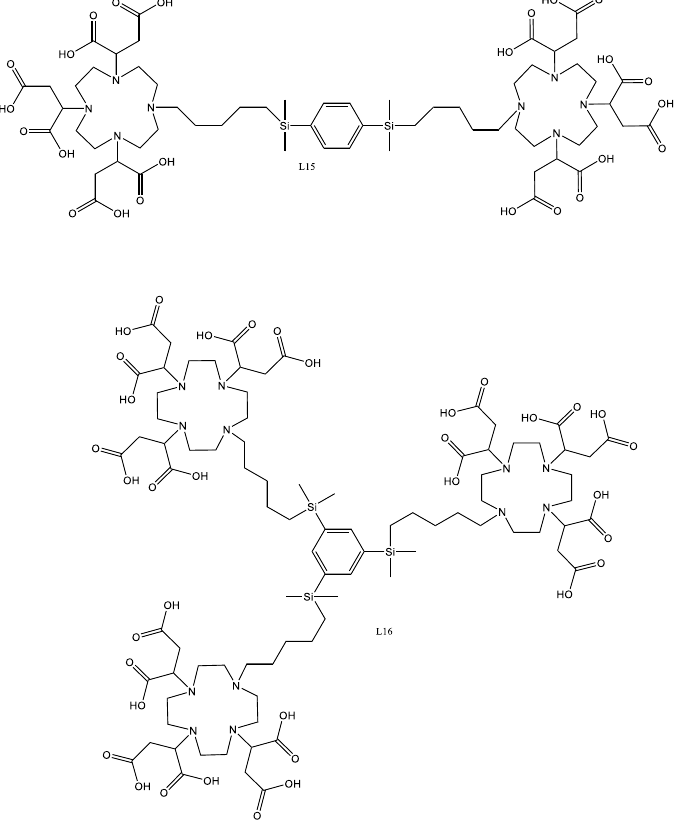
Figure 7. Structures of the bis- (L15) and tris (L16) substituted scaffolds with free acid ligands.